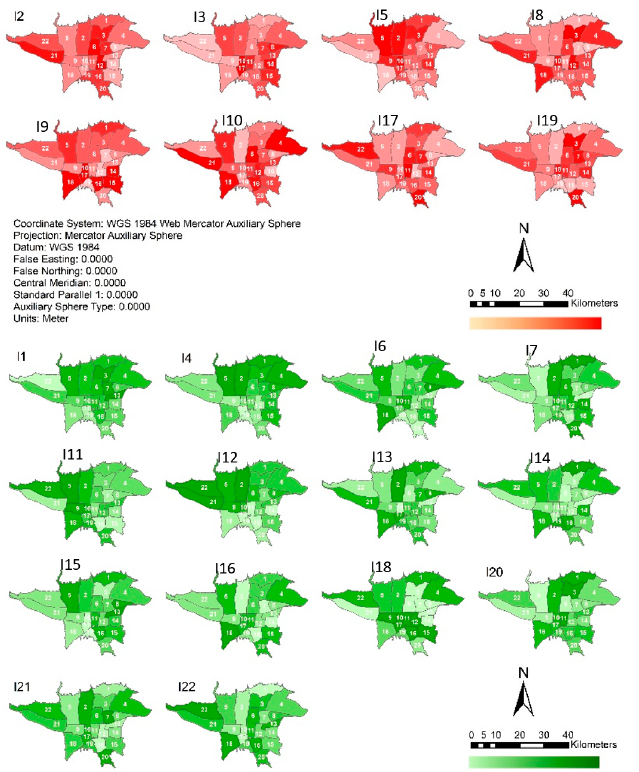
Figure 8. The visualized resilience indicators, in which red and green ramps account for negative and positive contributions to the resilience process,